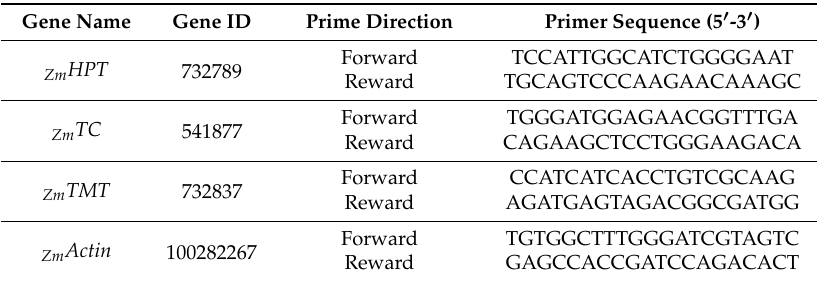
Table 3. Real-time PCR primers of relative